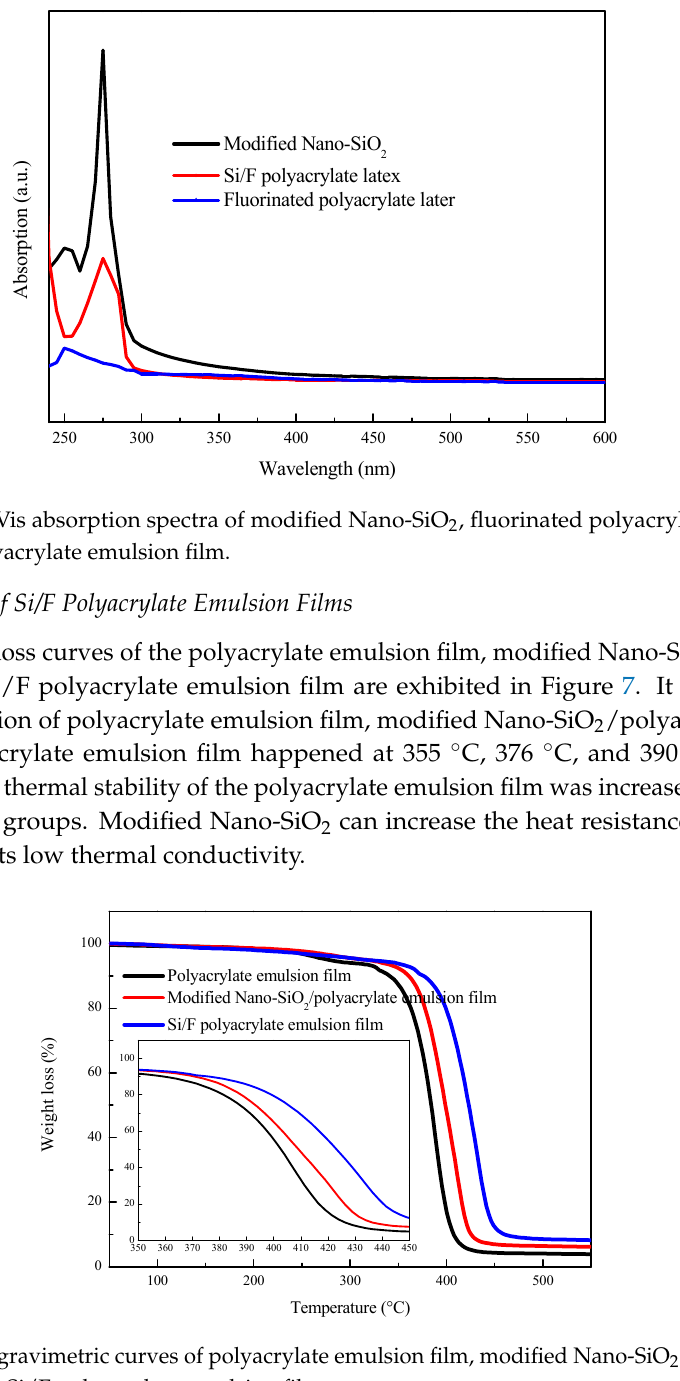
Figure 7. Thermal gravimetric curves of polyacrylate emulsion film, modified Nano-SiO 2 /polyacrylate emulsion film, and Si/F polyacrylate emulsion film.